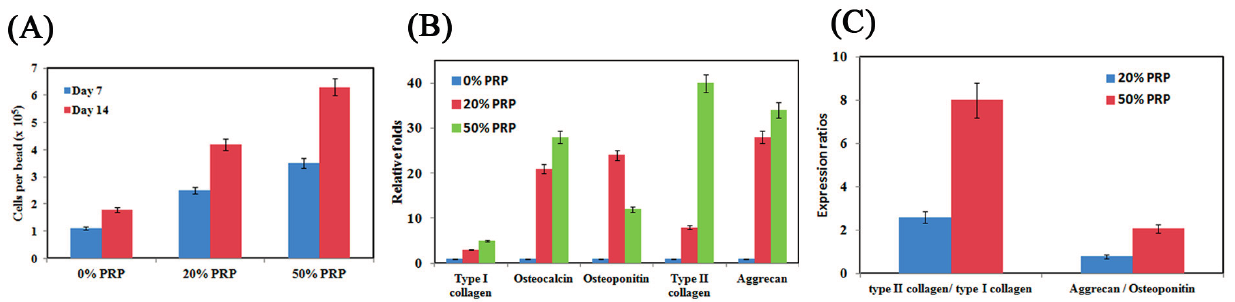
Figure 5. The differentiation potential effects of SF-MSCs among 0%, 20% and 50% platelet-rich plasma (PRP). Cell proliferation either on 7-day or on 14-day cultivation ( A ); gene expression after 14-day cultivation ( B ); and the ratios of type II collagen/type I collagen and aggrecan/osteopontin after 14-day cultivation ( C ). Three SF-MSCs samples were performed for this